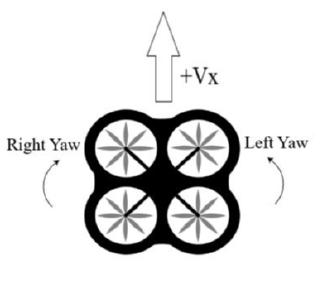
Figure 9. Action